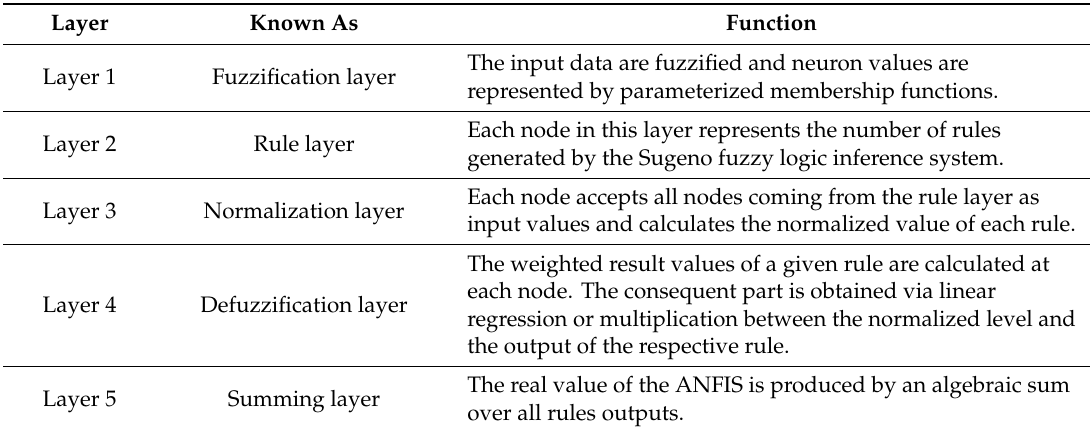
Table 1. ANFIS layer